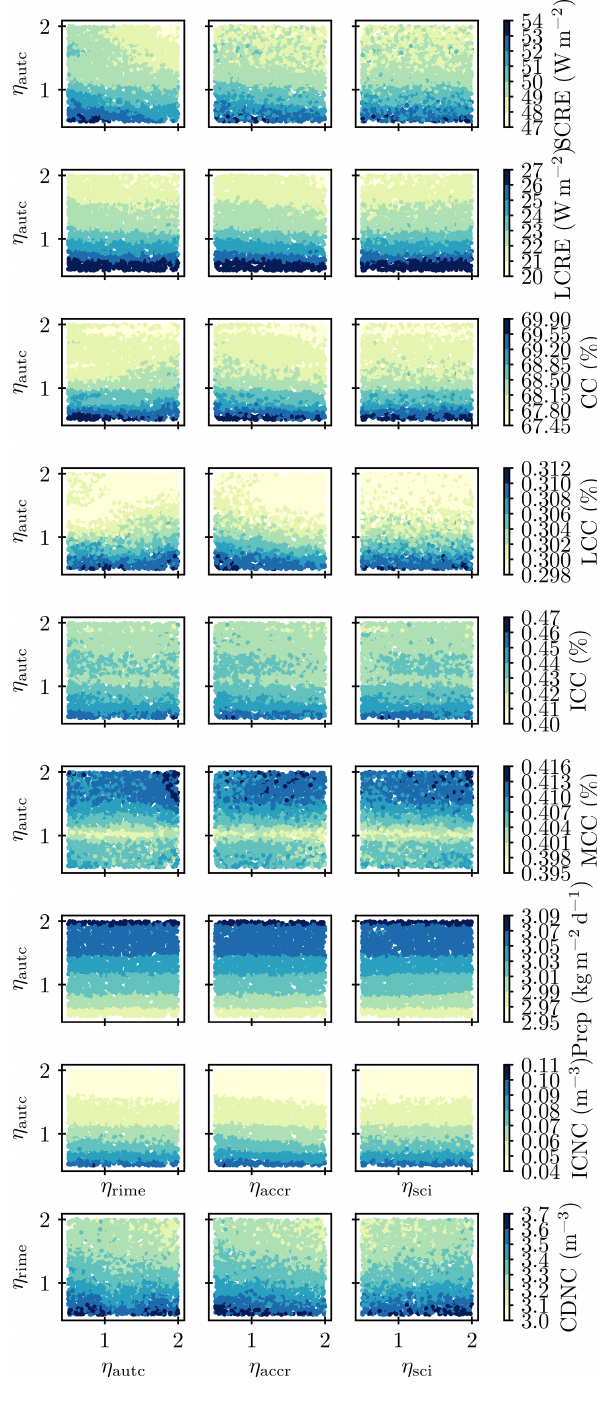
Figure B1. Visualization of the multidimensional response surfaces of the emulated PPEs for multiple variables. Each process is a di- mension, and the color bars denote the global annual mean values. In principle, each surface could be displayed by a full matrix plot as in Figs. 7 and 8, but here only the panels that include the domi- nating process are shown (autoconversion, except for CDNC in the last row, where riming is the dominant